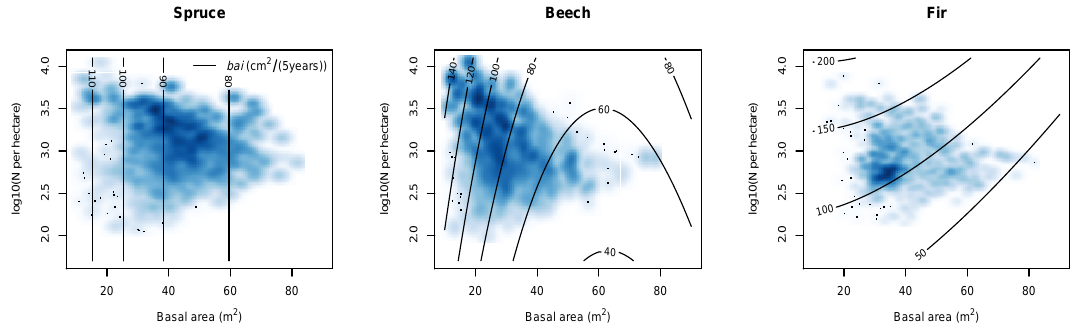
Figure 7. Interacting effects of basal area total ( bat ) and total stem number per hectare ( nt ). The blue in the background is the two-dimensional density of the observed bat and nt . Dark blue contains more